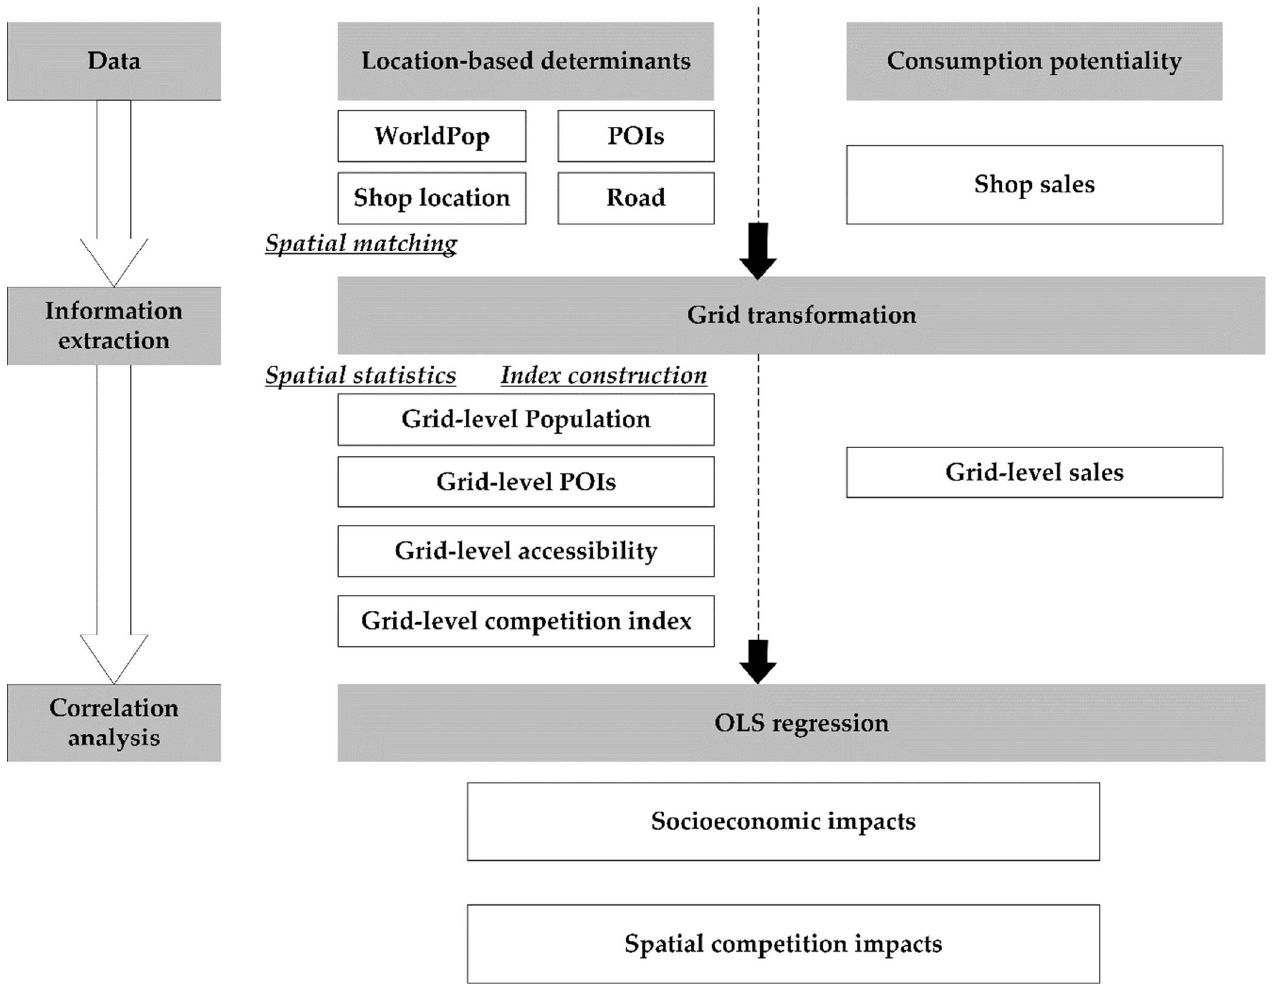
Figure 2. Flowchart of the study.